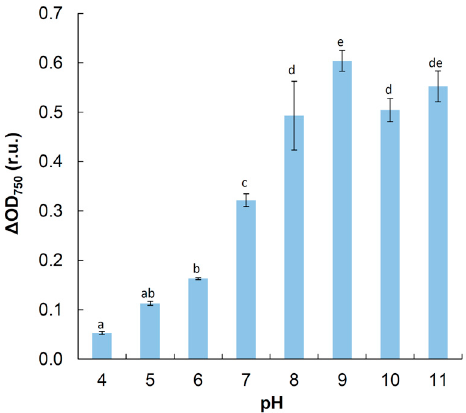
Figure 7. Growth of Neochlorella semenenkoi IPPAS C-1210 at different initial pH values. The error bars show standard deviations of the mean ( n = 3). The variants with the same letter are not signifi- cantly different (one-way ANOVA analysis, post hoc Tukey HSD test; p < 0.05). One representative experiment out of two is shown.